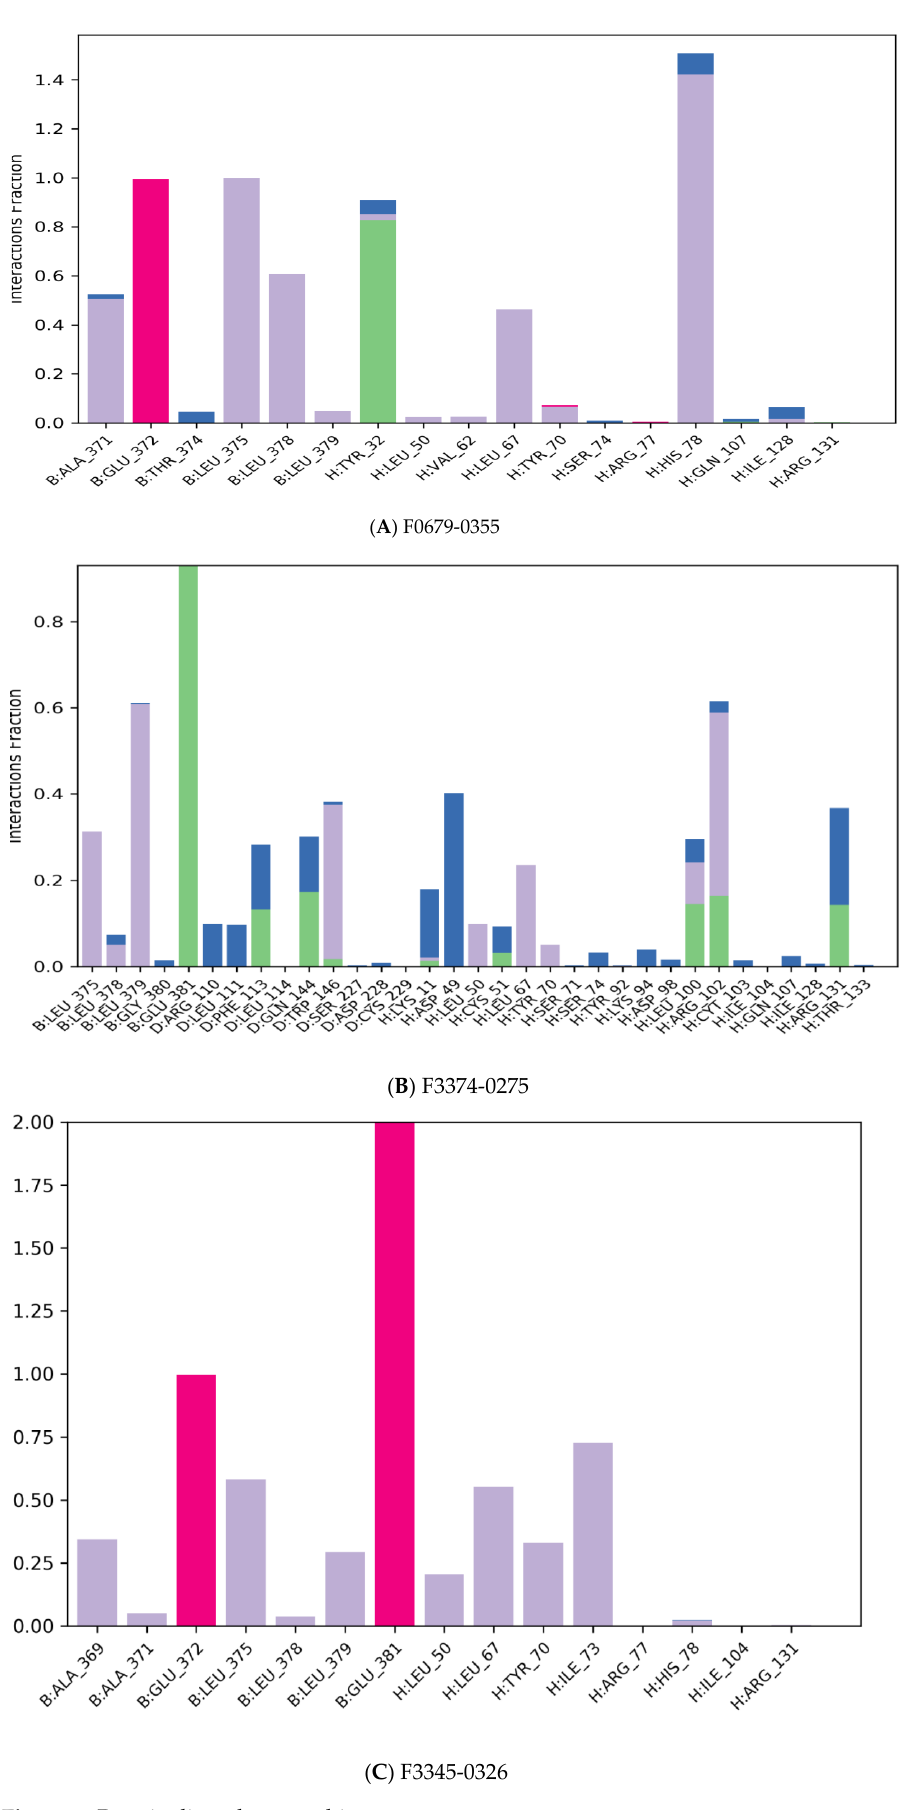
Figure 8 . Protein – ligand contact histogram . Figure 8. Protein–ligand contact